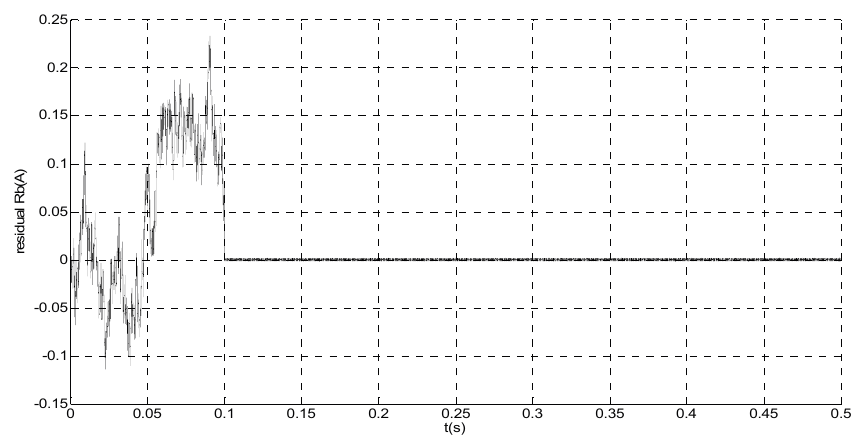
Figure 8. Simulation result of current residual in phase ‘b’.